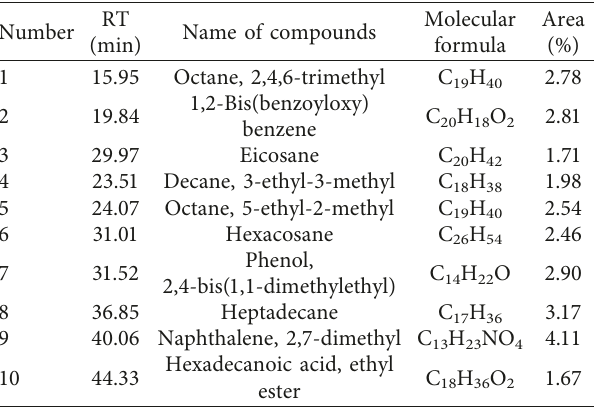
Table 7: Major chemical compositions of bio-oil from hydro- thermal liquefaction of fresh Spirulina sp. biomass at the con- centration of 10.5%, temperature of 357 ° C, and holding time of